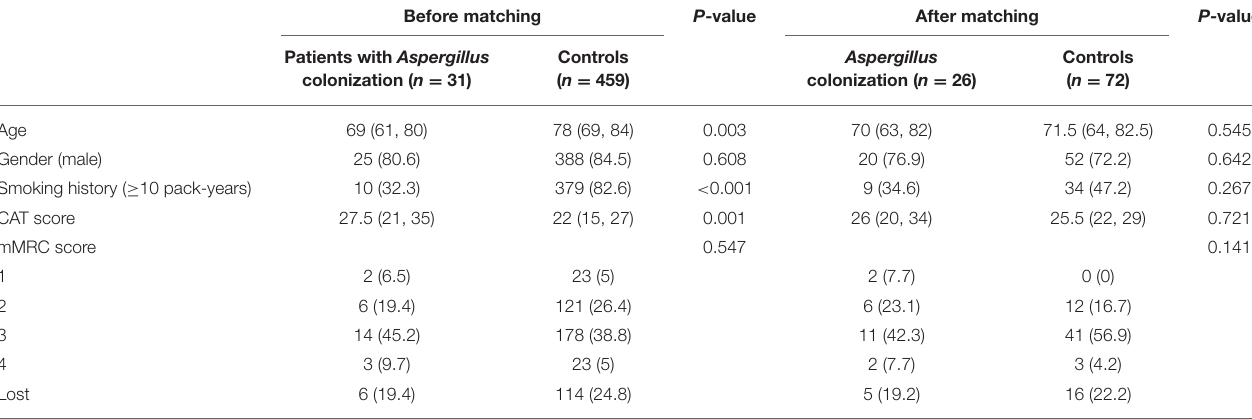
TABLE 1 | Baseline characteristics of hospitalized COPD patients with and without lower respiratory Aspergillus colonization before and after propensity score matching. Before matching P -value After matching P -value Aspergillus Patients with Aspergillus Controls Controls colonization ( n = 31) ( n = 459) colonization ( n = 26) ( n =